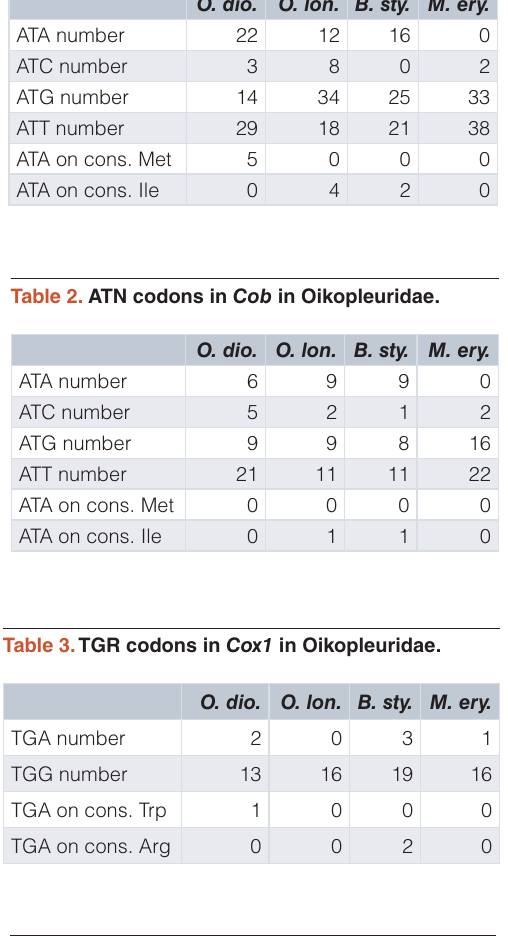
Table 4. TGR codons in Cob in Oikopleuridae.